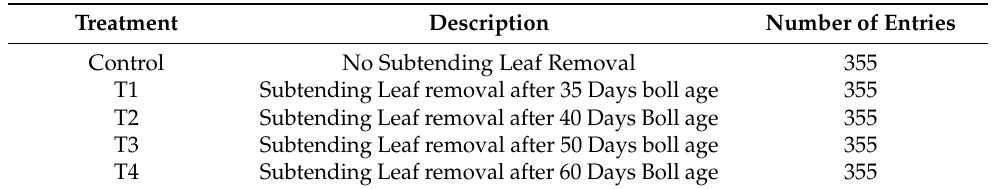
Table 1. Description of subtending leaf removal of 355 cotton accessions to determine the source- sink